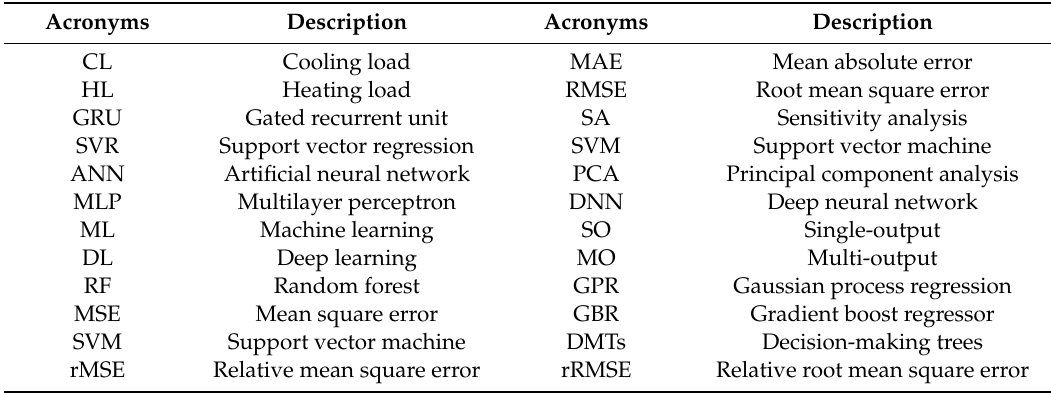
Table 2. Parameters and their